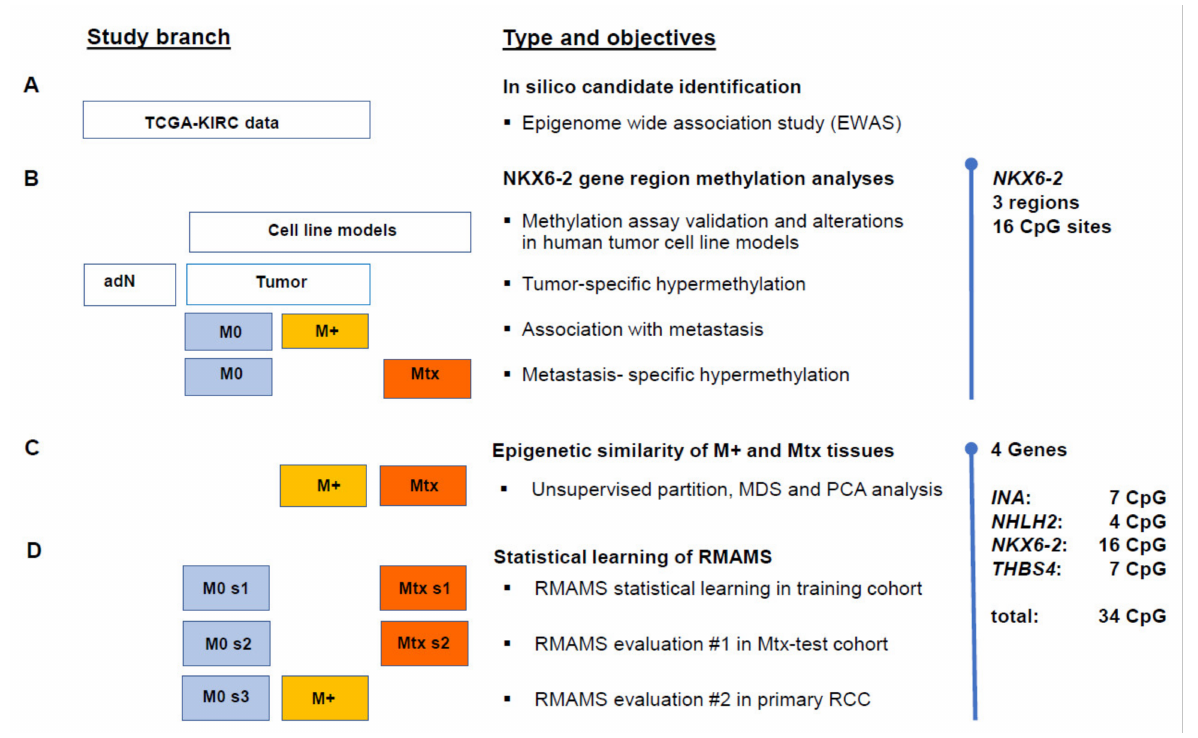
Figure 1. Study design. ( A ) Boxes illustrate data of the TCGA KIRC, cell models ( B ) or renal and metastatic tissues ( C , D ). The columns of the boxes represent tumor-adjacent normal renal tissues (adN), primary renal tumor tissues without (M0, blue shading) and with distant metastasis (M+, yellow shading), and renal metastatic tissues (Mtx, orange shading). ( B ) Relevance of NKX6-2 methylation was investigated using the average of methylation of 16 CpG sites in three gene